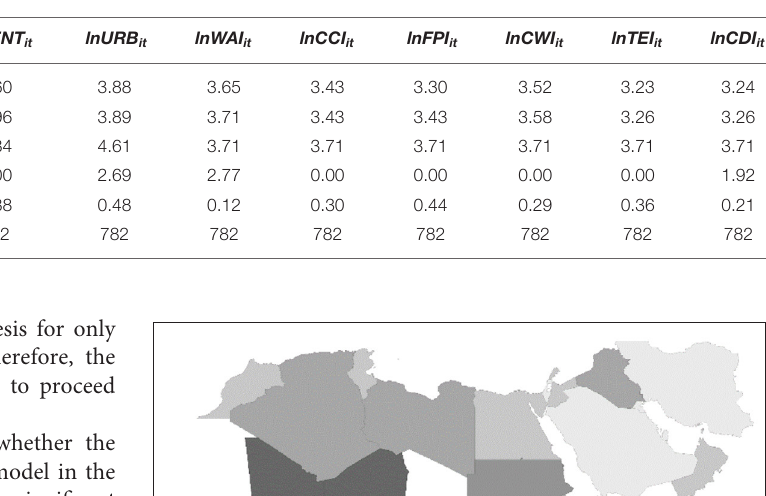
TABLE 2 | Summary of statistics during 2001–2017.